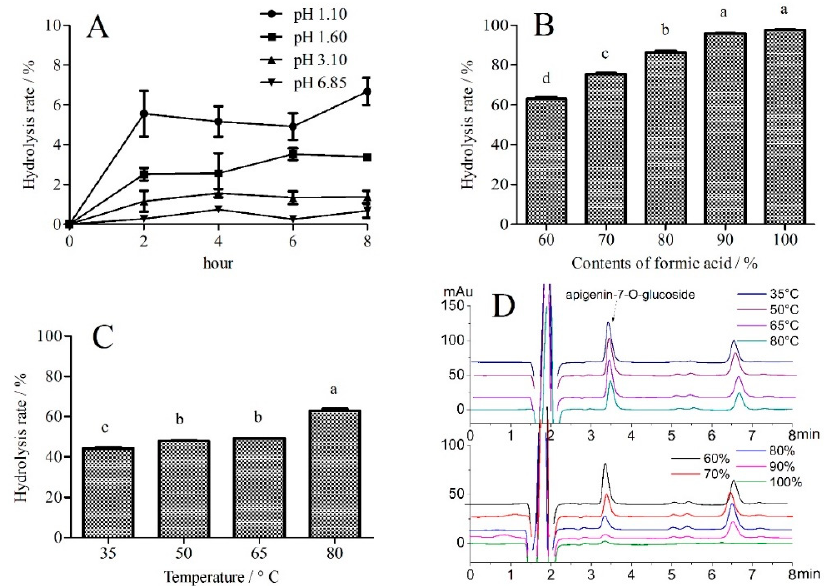
Figure 4. Hydrolysis behavior of apigenin-7-O-glucoside. ( A ) pH values from 1.10 to 6.85 at 80 ◦ C; ( B ) content of formic acid from 60 to 100% at 80 ◦ C; ( C ) temperatures from 35 to 80 ◦ C with 60% formic acid; and ( D ) HPLC spectrograms about the contents of formic acid and temperature. Means indicated by different letters differed significantly with a value of p < 0.01.